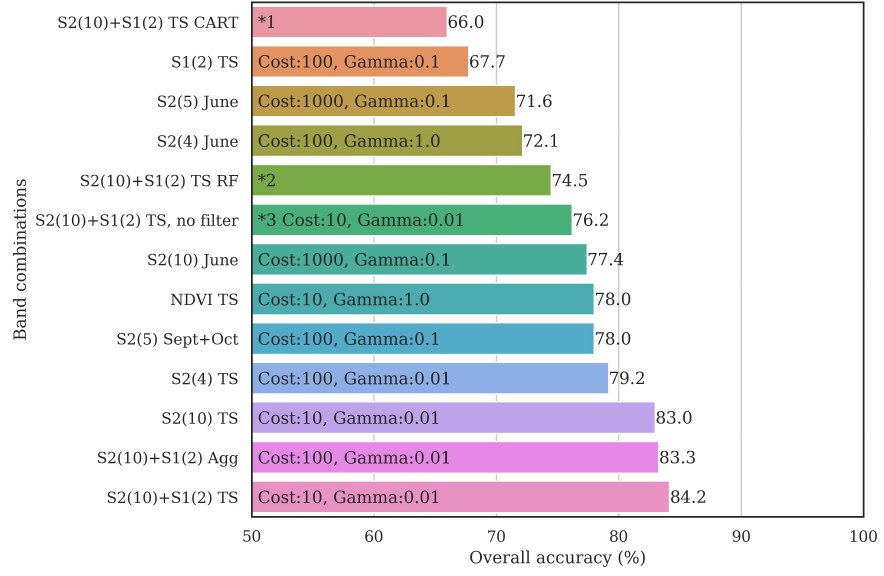
Figure 14. Overall accuracy of object-based classified maps generated from the segmented image, assessed using the random validation segments. All results are using the SVM classifier with RBF apart from those marked “CART” and “RF”. Optimal SVM RBF parameters used for each classification are shown on the bars. Additional notes: *1 CART parameters: MinSplitPoplulation:1, MinLeafPopulation:1, MaxDepth:10. *2 RF parameters: NumberOfTrees:128, VariablesPerSplit:16, MinLeafPopulation:2. *3